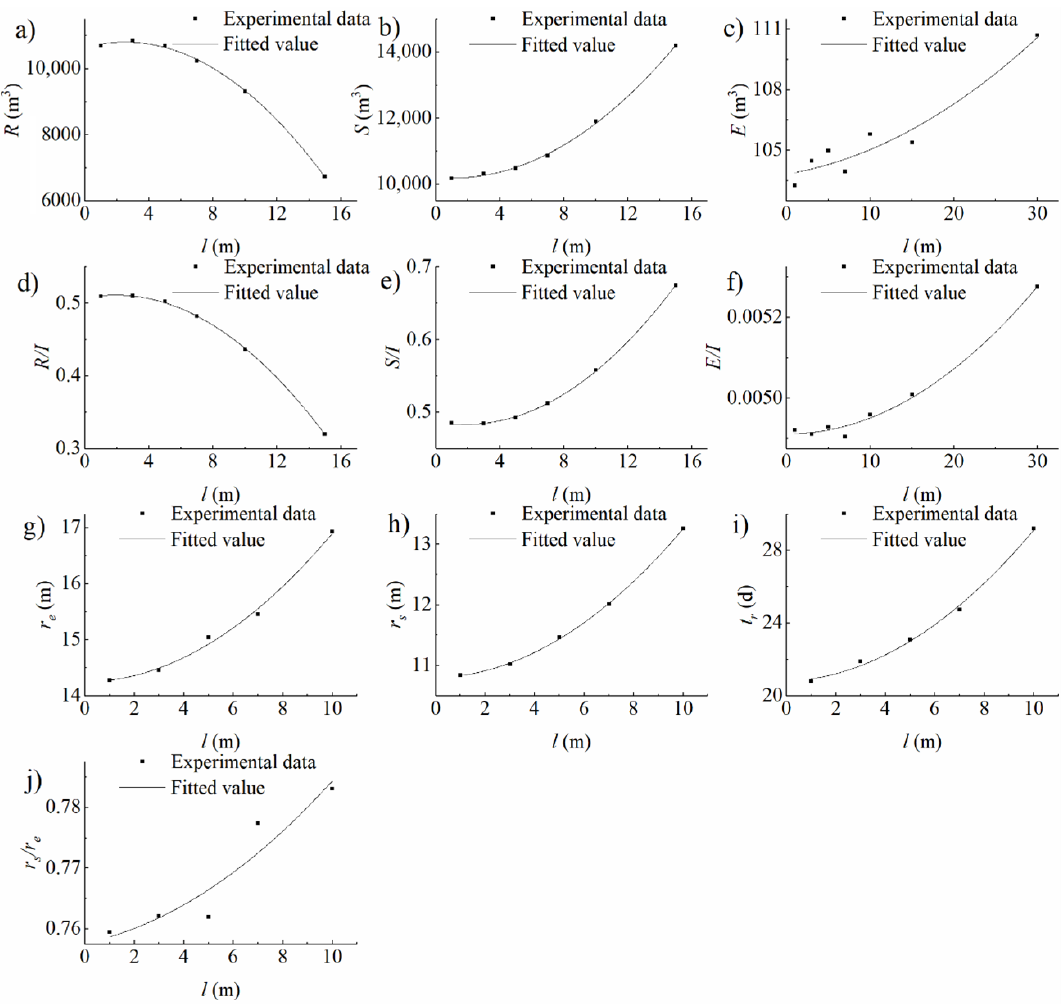
Figure 11. The variations with an increment in l when the depth is 30 m. (( a ) variation of R; ( b ) variation of S; ( c ) variation of E; ( d ) variation of R/I; ( e ) variation of S/I; ( f ) variation of E/I; ( g ) variation of r e ; ( h ) variation of r s ; ( i ) variation of t r ; ( j ) variation of r s /r e .).